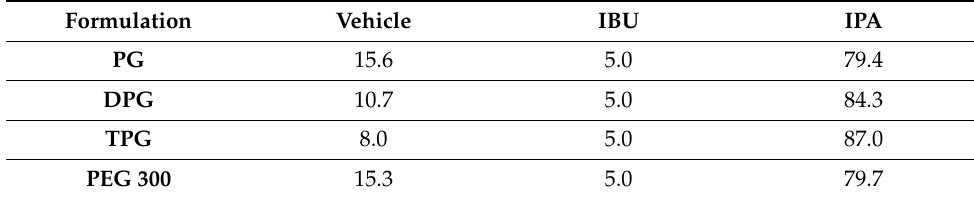
Table 2. Quantities of formulation components expressed as % ( w / w